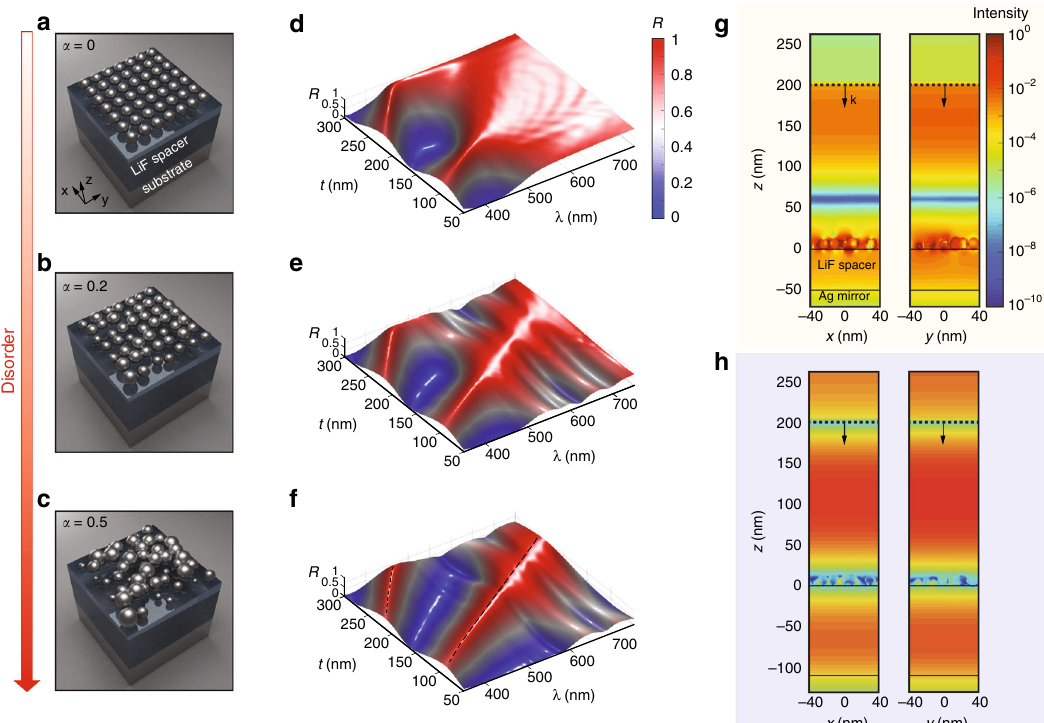
Fig. 2 3D full-wave simulations for the disordered plasmonic system with deterministic coupling to the optical environment. a – c Schematic diagram of platforms with different disorder parameters α for a α = 0, b α = 0.2, c α = 0.5. d – f The corresponding re fl ection spectra R as a function of spacer thickness from FDTD simulations. d corresponds to setup in a , e corresponds to setup in b while f corresponds to setup in e . Interestingly, the introduction of disorder creates and narrows the re fl ection peaks. A prominent transition from broadband absorption to turnable re fl ection is observed in f . g , h Spatial distributions of the electrical fi eld intensity in x – z and y – z plane for g t = 50 nm and h t = 110 nm. A plane wave is launched at z = 200 nm (blacked dashed lines) along the y direction with wavelength λ = 400